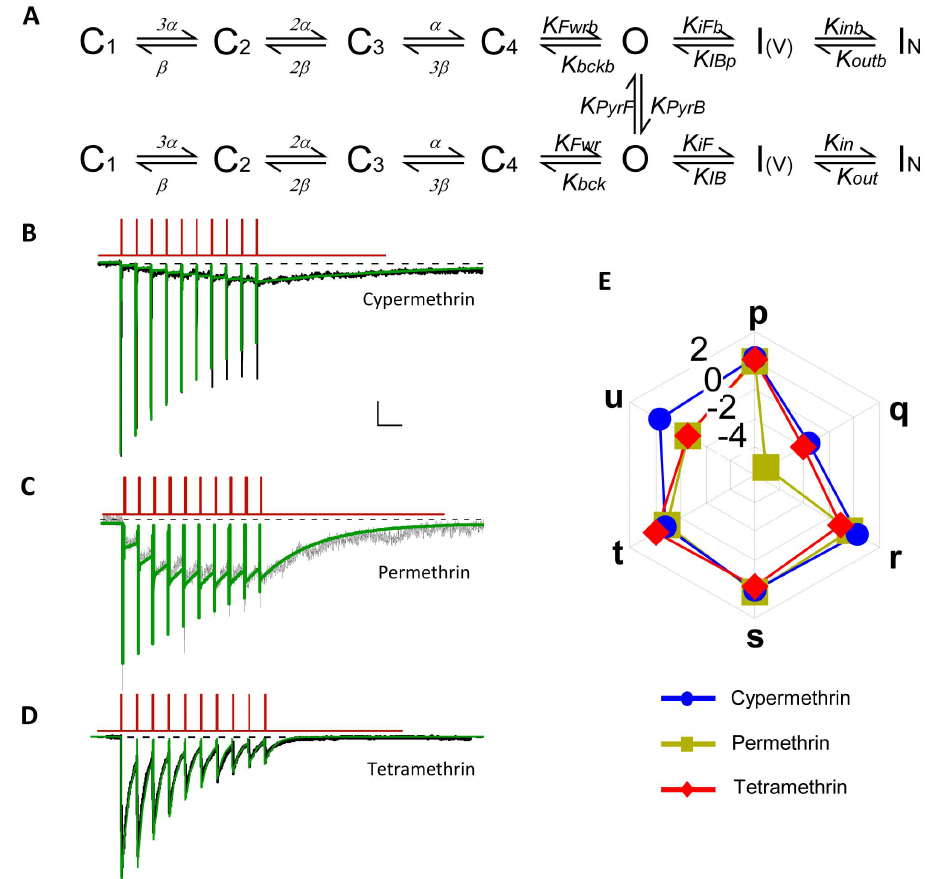
Figure 6. Pyrethroids decrease deactivation rate constants. A. State model used to fit the experimental traces (see Methods and text for details). Pyrethroids can only bind to open channel. Once bound they modify channel kinetics to and from open and inactivated states by given factors, i.e. KFwr, Kbck, KiF, KIB, Kin and Kout by p, q, r, s, t, and u respectively to give KFwrb, Kbckb, KiFb, KIBb, Kinb and Koutb. Voltage dependence is not changed. B-C-D. Fitting of experimental traces obtained under differents pyrethroids (cypermethrin, permethrin, tetramethrin) using the above model allows to determine the changes in the different kinetic parameters. Scale bar 200 pA (B and C) or 500 pA (D) and 150 ms. E. Radargraph of the changes (logarythmic scale) in the different kinetic parameters produced by pyrethroids. Fitting for KpyrF KpyrB, the binding and unbinding rate constants at a single concentration (10 m M), are used to calculate Kd.